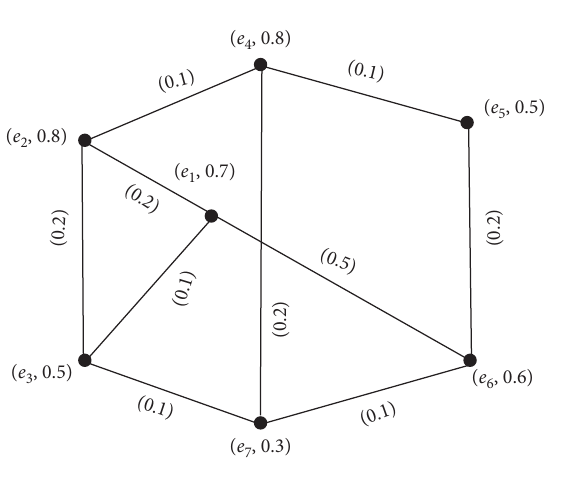
Figure 3: Fuzzy graph G � ( J , K )